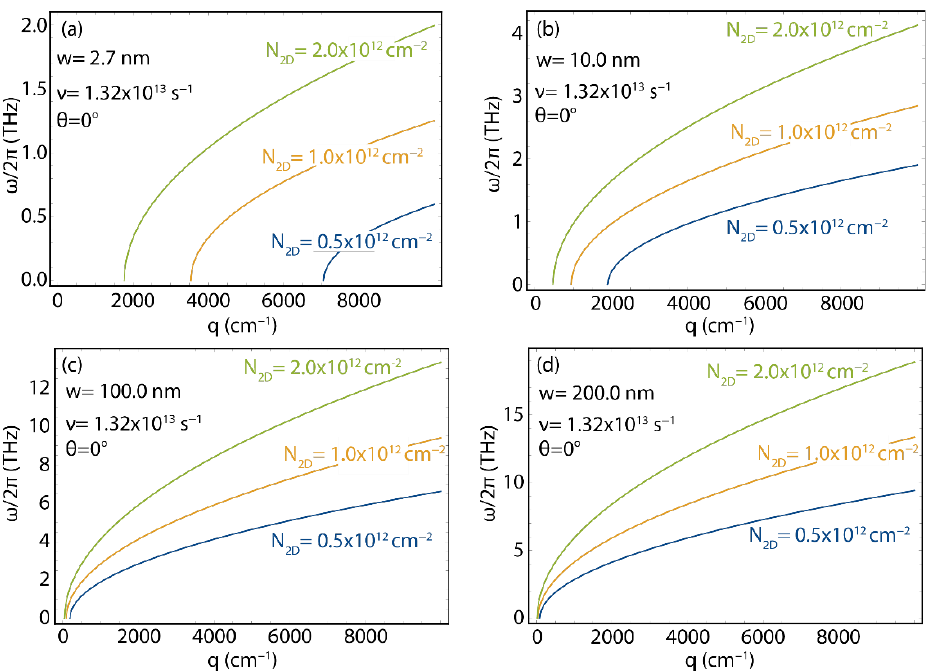
Figure 10. Plasmon energy dispersion relation, as obtained using Equation (5) (with v F = 0.829 × 10 6 m/s, 𝜈 = 1.32 × 10 13 s − 1 , and 𝜃 = 0 ) for different values of 2D charge density ( 𝑁 2𝐷 ), considering four different ribbon widths: 𝑤 = 2.7 nm ( a ), 𝑤 = 10 nm ( b ), 𝑤 = 100 nm ( c ), and 𝑤 = 200 nm ( d ). The corresponding effective masses ( 𝑚 ∗ ) are reported in Table S4.